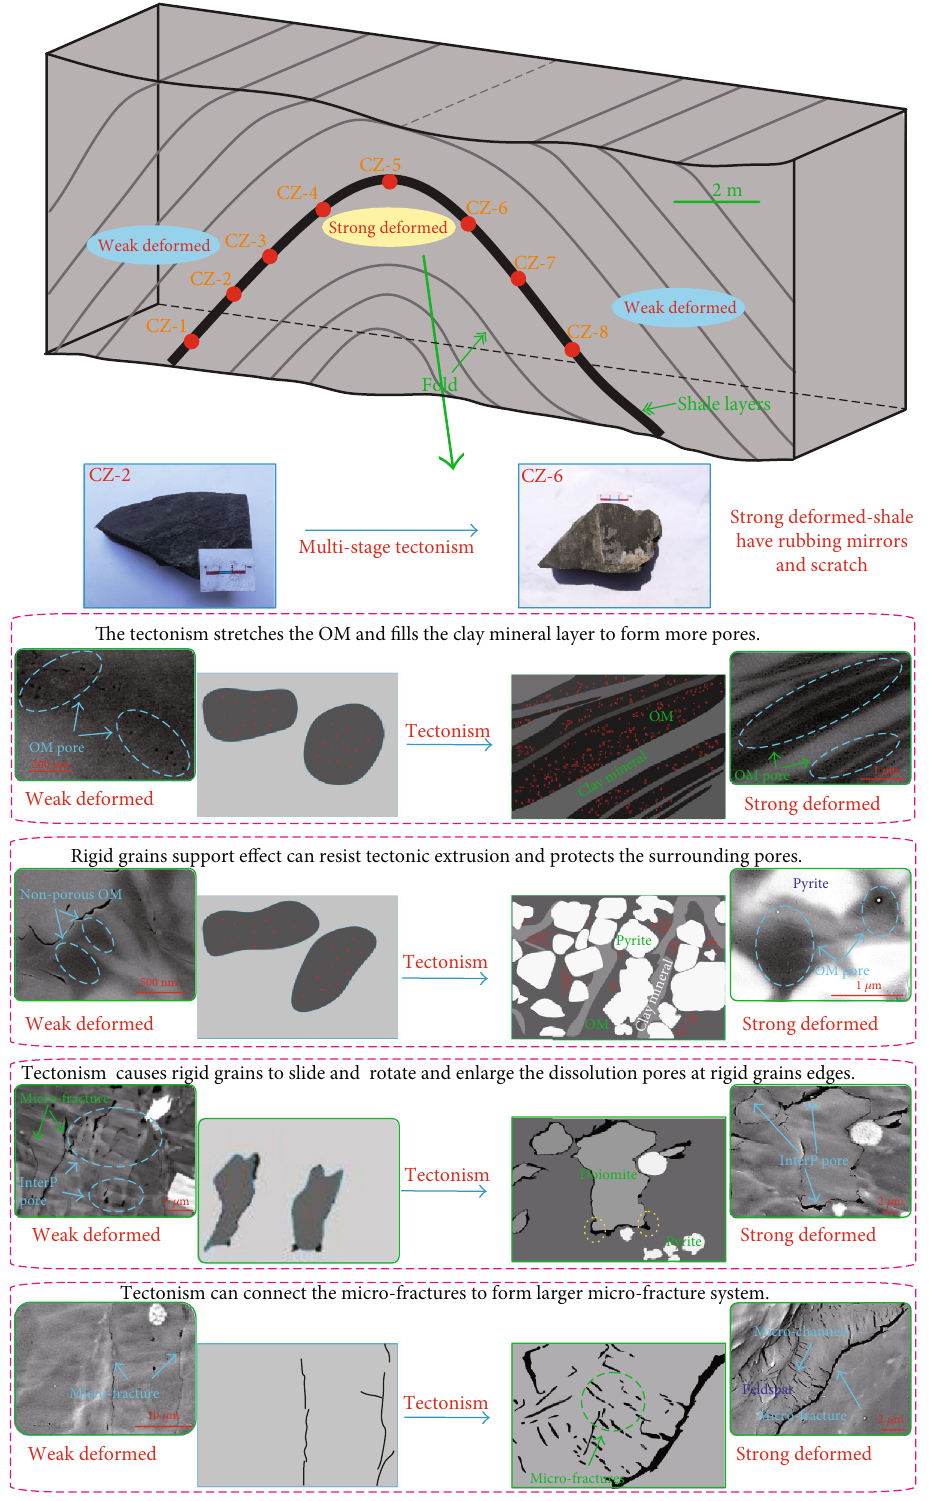
Figure 11: Evolution of pore structure in samples with di ff erent tectonic